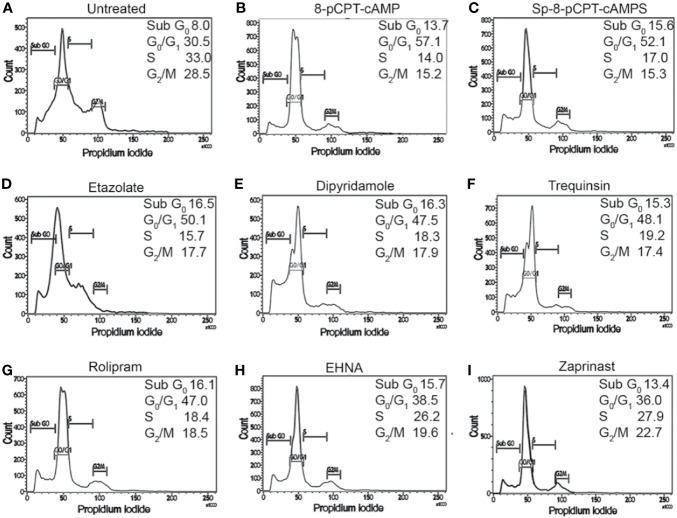
Impact of cAMP analogs and PDE inhibitors on cell cycle progression of L. donovani promastigotes. G1-synchronized log phase promastigote populations, either untreated (A) or treated with 8-pCPTcAMP (100 μM) (B), Sp-8-pCPTcAMPS (100 μM) (C); etazolate (D), dipyridamole (E), trequinsin (F), rolipram (G), EHNA (H) or zaprinast (I) (50 μM each) for 8, 16, and 24 h, were analyzed for cell cycle progression by propidium iodide staining based FACS analysis (Tables S1–S3). Representative histograms from 24 h data are presented.